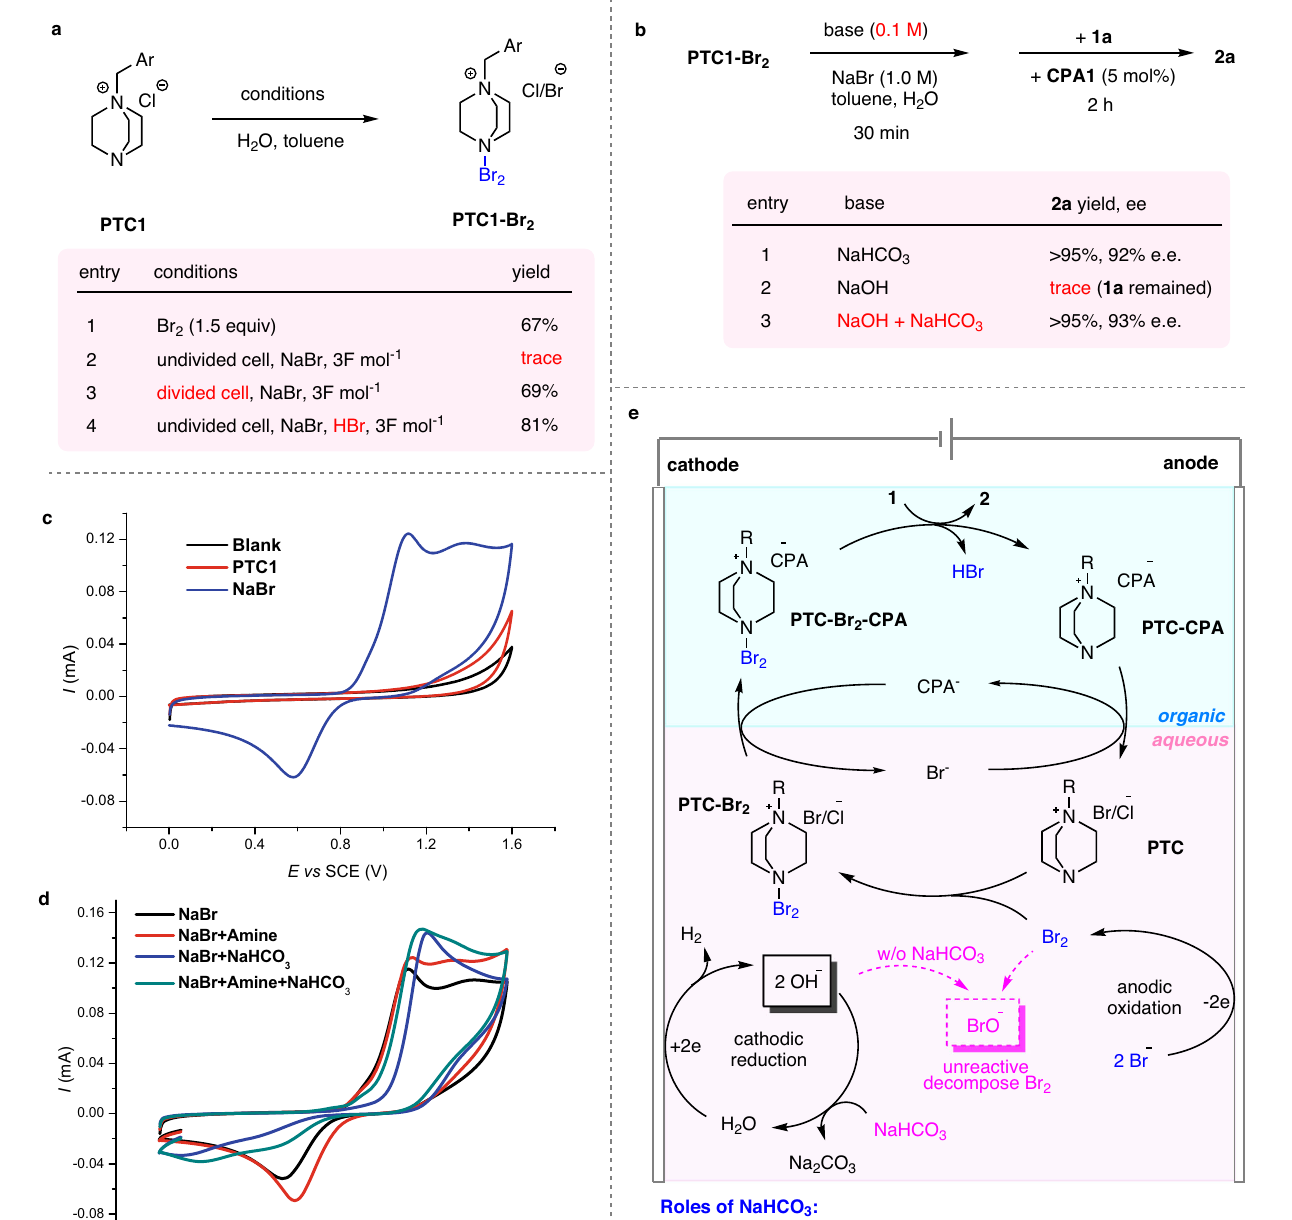
decompositionandrecoveredthedesiredreactivity,whichmimickedthestandard condition. c , d Cyclic voltammetry measurements in H 2 O with 0.1M NaNO 3 and 5mM substrate at room temperature with a scan rate of 100mVs − 1 . e Detailed mechanism including the roles of NaHCO 3